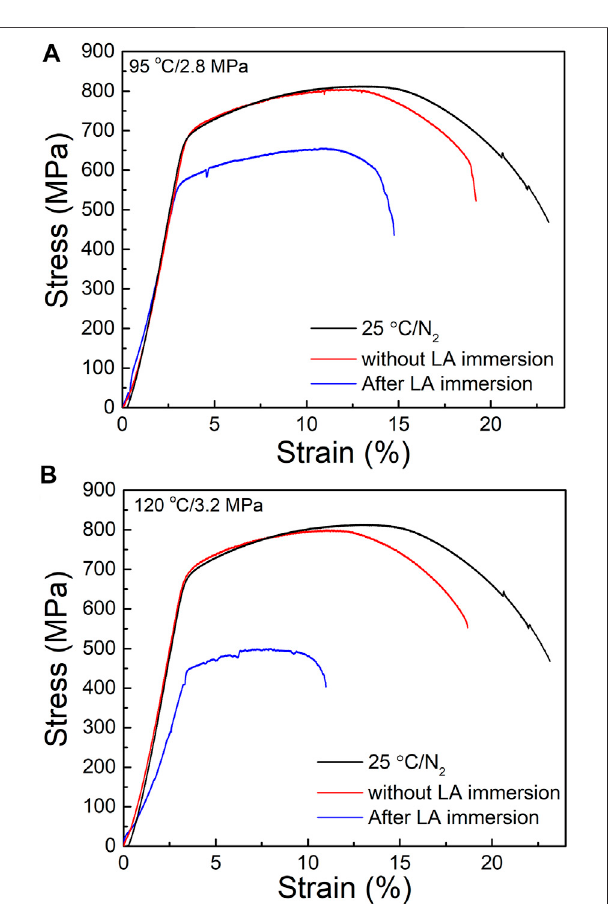
FIGURE 4 | Stress – strain curves of HP-13Cr SS in the FW at 25 ° C/N 2 atmosphere and at (A) 95 ° C/2.8MPa CO 2 and (B) 120 ° C/3.2 MPa CO 2 after LA immersion,